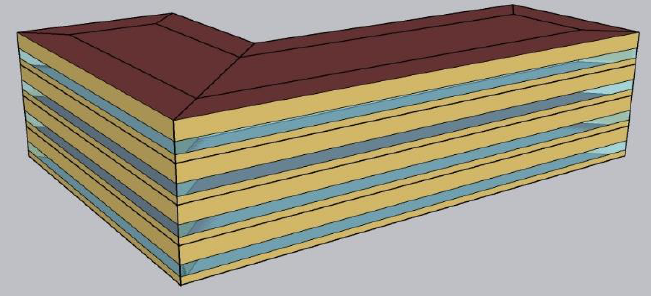
Figure 2. A four-story office building.